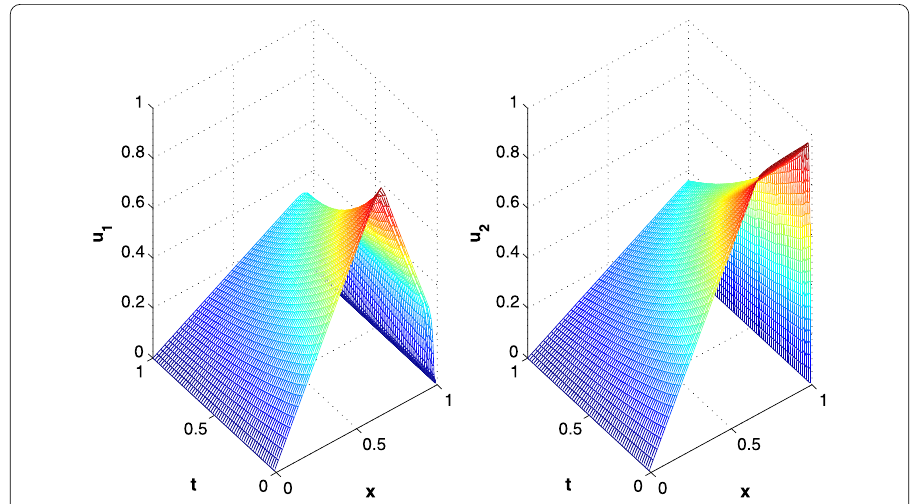
Figure 6 Numerical solution of Example 5.2 for N = M = 64, ε 1 = 10 –2 , and ε 2 = 10 –4